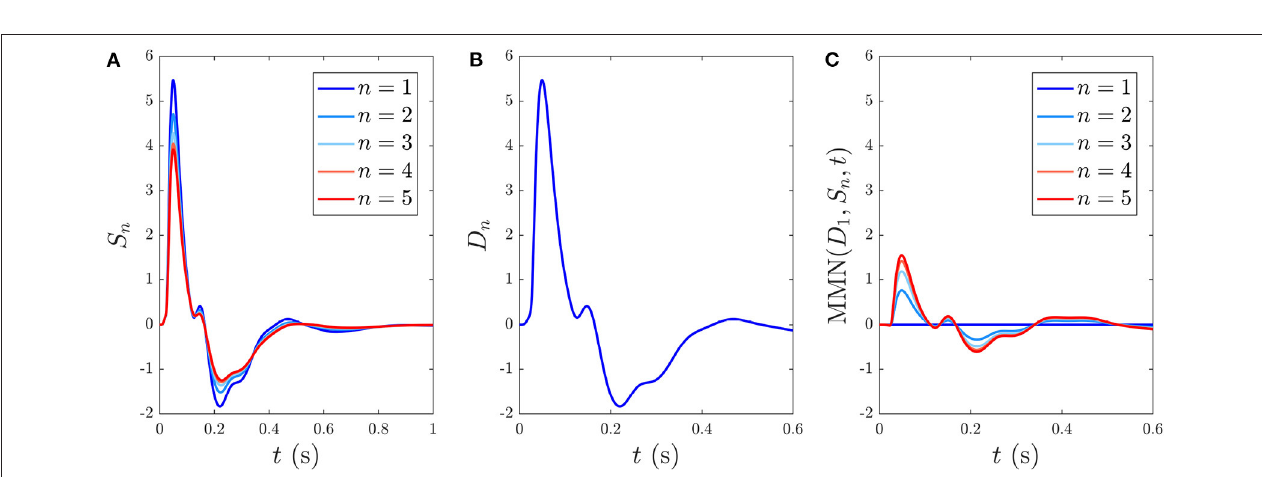
FIGURE 5 | ERs and gain contributions corresponding to different responses. (A) Static gain baseline ER starting from P, fast gain modulation 1 g S 1 h S contributions which, when added together ( 1 g ∞ gain modulation 1 g D , and adaptation 1 h D contributions which, when added together ( 1 g MMN( D , S , t ) and the corresponding isolated fast gain modulation (magenta broken line) and adaptation (black broken line) contributions. ∞